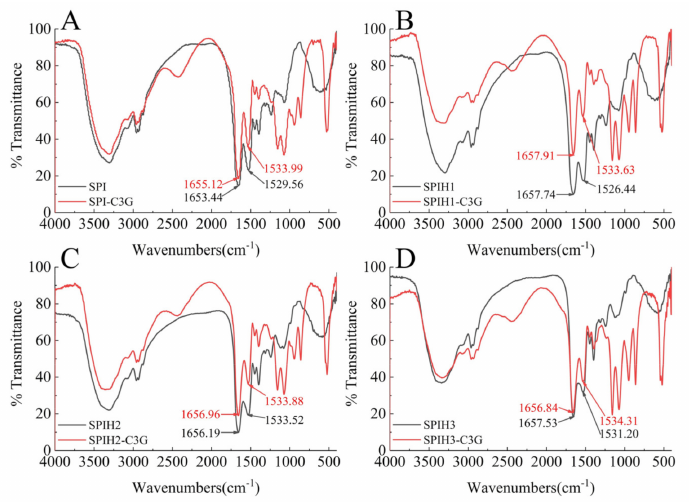
Figure 3. FTIR spectra of 100 µ g/mL SPI ( A ) and SPIH1–3 ( B – D ) with or without 1 µ g/mL C3G at pH